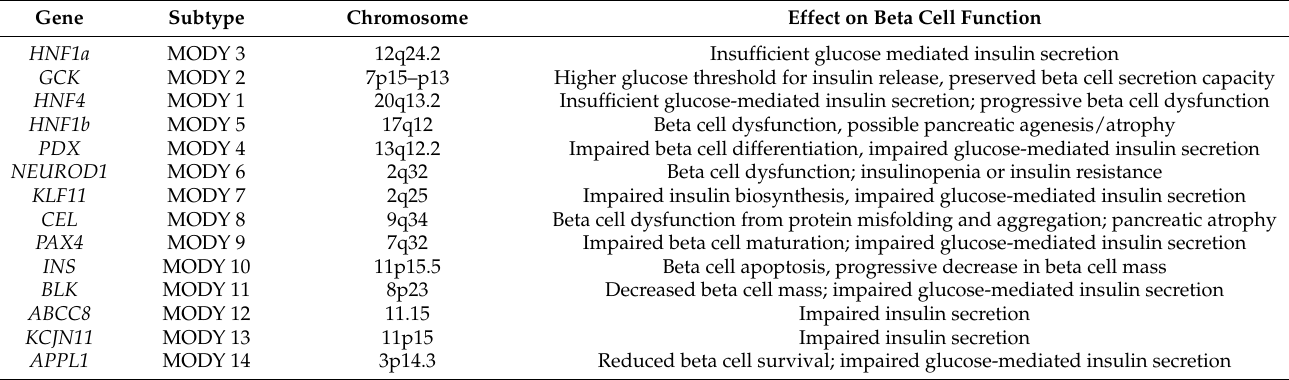
Table 1. MODY Subtypes, associated genes, chromosome locus, and effect of gene mutation on beta cell function.